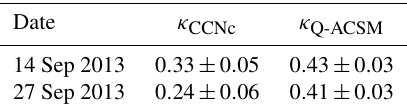
Table 5. Mean κ for the ground-based measurements of the CCNc and Q-ACSM recorded between 08:00 and 15:00UTC for the here investigated days.